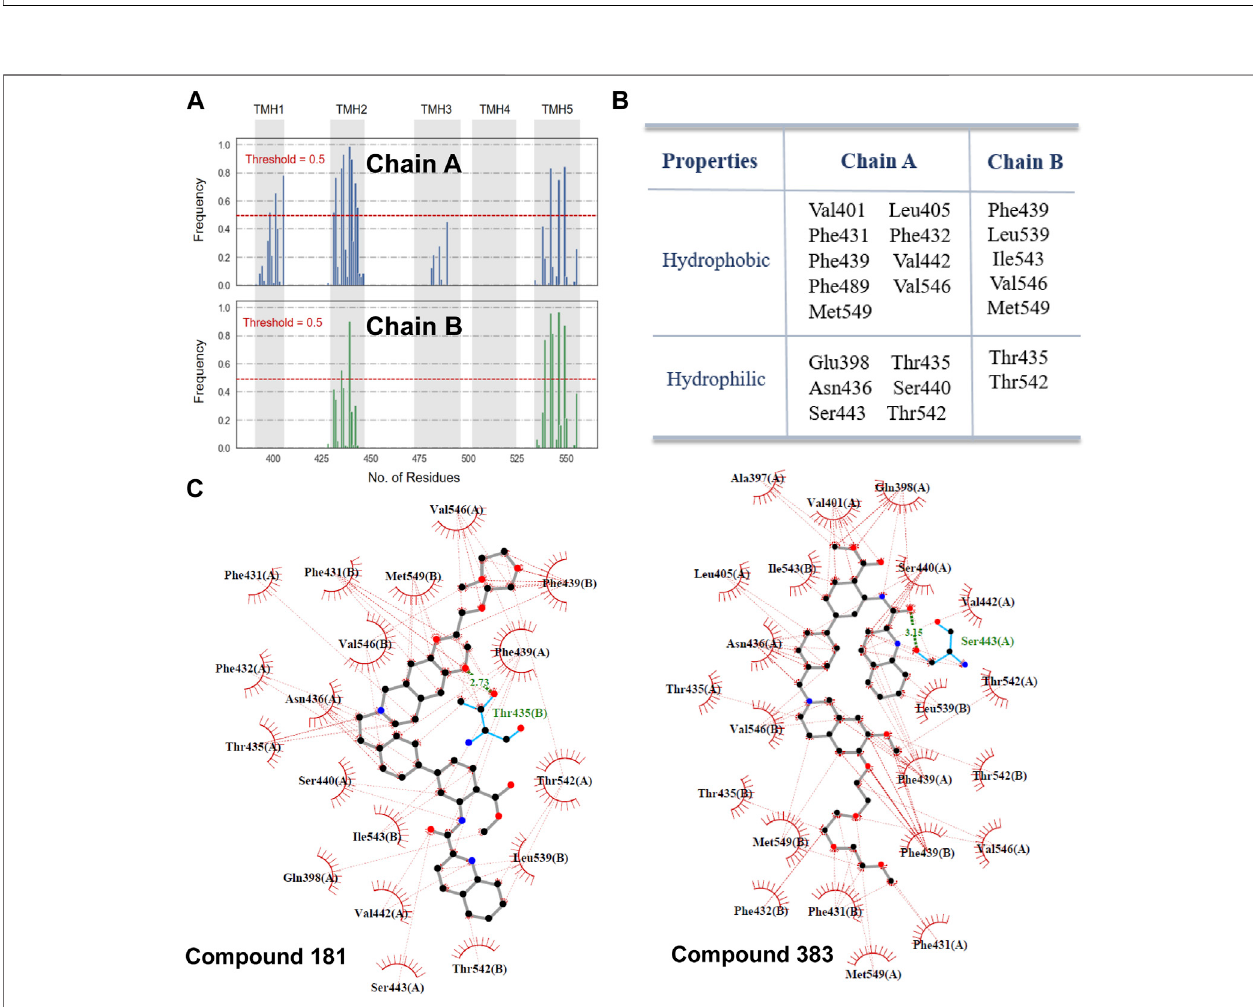
FIGURE 4 | Molecular interactions with ABCG2. (A) The occurrence frequencies of the binding residues involved in the molecular interactions with the docked inhibitors. (B) 22 hotspot residues with ahigh-frequency occurrence ( > 0.5) intimatelyrelated to the binding of inhibitors. (C) Interactionsof compound 181 and 383 with the residues in the binding pocket. H-bonds interactions are represented as green dashed lines.